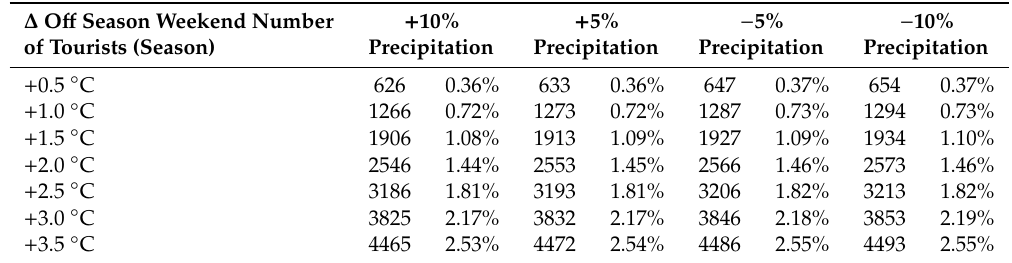
Table 12. O ff season number of weekend tourists increase (persons per season) and increate rate (%).